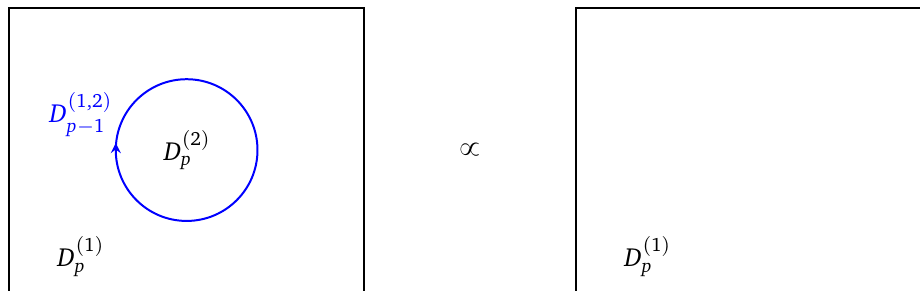
are related by condensation if there and D p 2 q p p which can be bubbled out of nothing at the cost p ´ 1